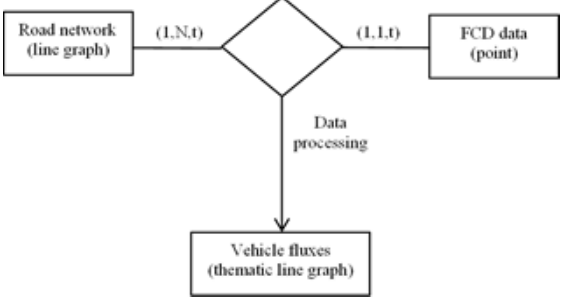
Figure 5. Example of a geodatabase embedded processing